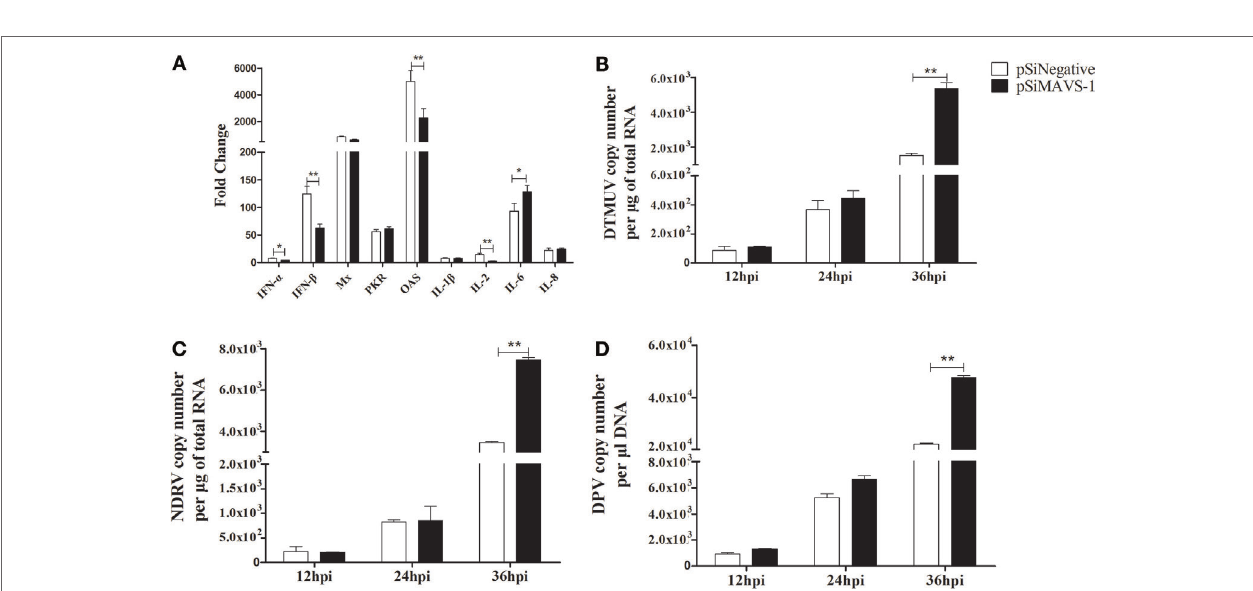
FigUre 8 | duMaVs knockdown reduces cytokines production and antiviral activity . (a) The DEFs were seeded in 6-well plates and first transfected with 2 μ g/well pSiMAVS-1 or pSiNegative control plasmid. After 20 h transfection, the cells were stimulated with pC-duMDA5-CARD-HA (2 μ g/well) for 12 h and then the cells were collected for cytokines detection by RT-qPCR. (B) The DEFs were transfected with 2 μ g/well pSiMAVS-1 or pSiNegative control plasmid. After 20 h, the cells were infected with DTMUV (100 TCID 50 ). The culture supernatants were collected for detecting the viral titers at 12, 24, and 36 hpi by RT-qPCR. The detection of (c) NDRV and (D) DPV were performed as the same as DTMUV. Data were means from three independent experiments. Student’s t test was performed to evaluate the differences. *Significant difference ( P < 0.05); **highly significant difference ( P < 0.01).